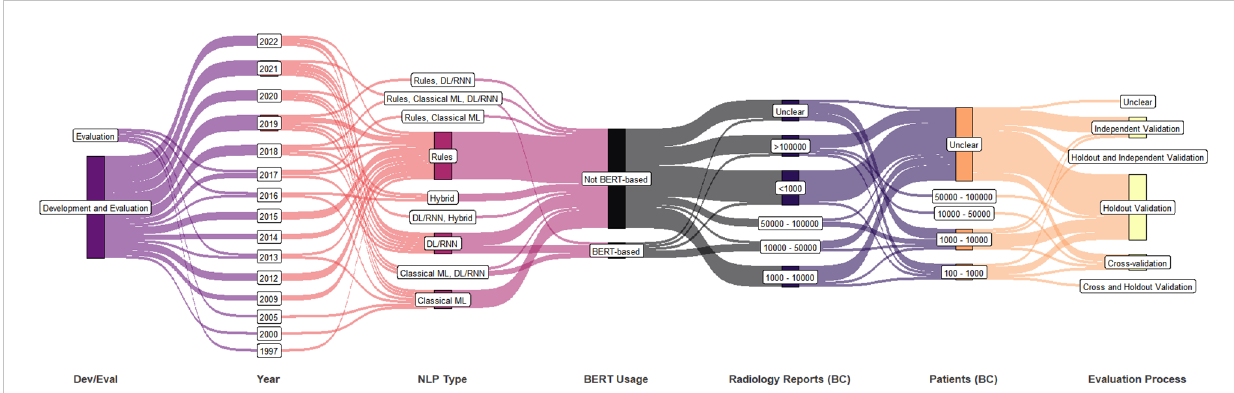
FIGURE 4 Synthetic analysis (Sankey plot) showing the relationship among NLP development and/or evaluation (Dev/Eval), year of publication, NLP approach, BERT usage, counts of breast cancer patients and radiology reports, and evaluation process. (DL, deep learning; ML, machine learning; RNN, recurrent neural network; BERT, bidirectional encoder representations from